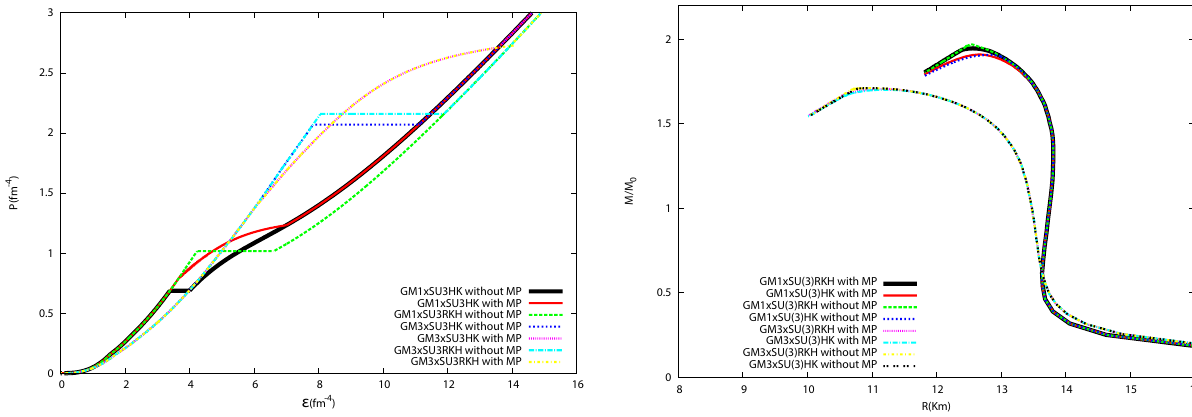
Figure 19. ( Left ) EOS built with Maxwell (without MP) and Gibbs (with MP) constructions; ( Right ) corresponding mass–radius diagram. Figure based on the results presented in